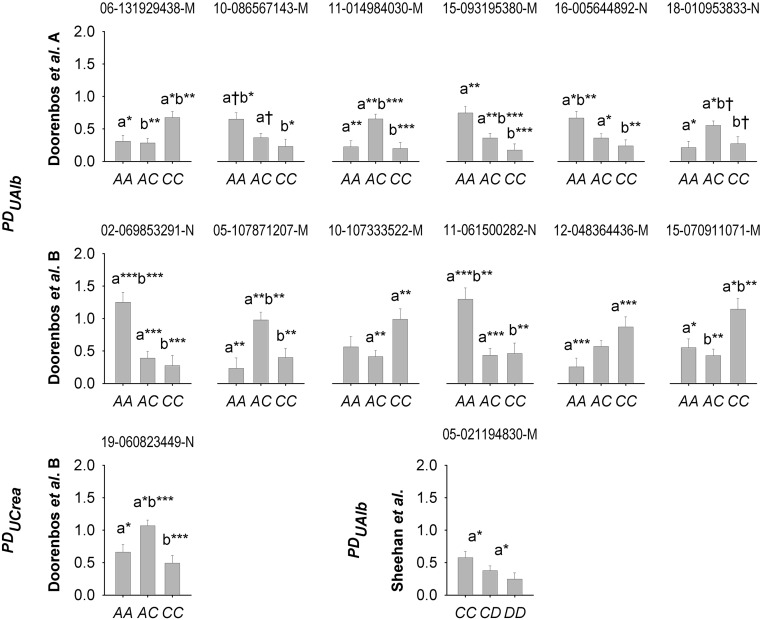
Mean dispersion in urinary albumin (PDUAlb) and creatinine (PDUCrea) by single nucleotide polymorphism (SNP) genotype for markers detected only in 383 male F2 C57BL/6J × A/J mice (‘Doorenbos et al. A’) or 207 male F2 C57BL/6J ApoE−/− × A/J mice (‘Doorenbos et al. B’) {Doorenbos, 2008 #25451}. SNP markers are indicated above each graph. Significant differences among genotypes for mean PD are indicated as PBon < 0.10†, < 0.05*, < 0.01**, < 0.001***.